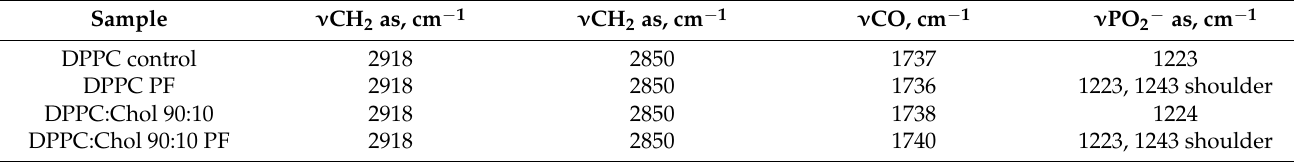
Table 3. Position of the main absorption bands in the ATR-FTIR spectra of liposomes of various